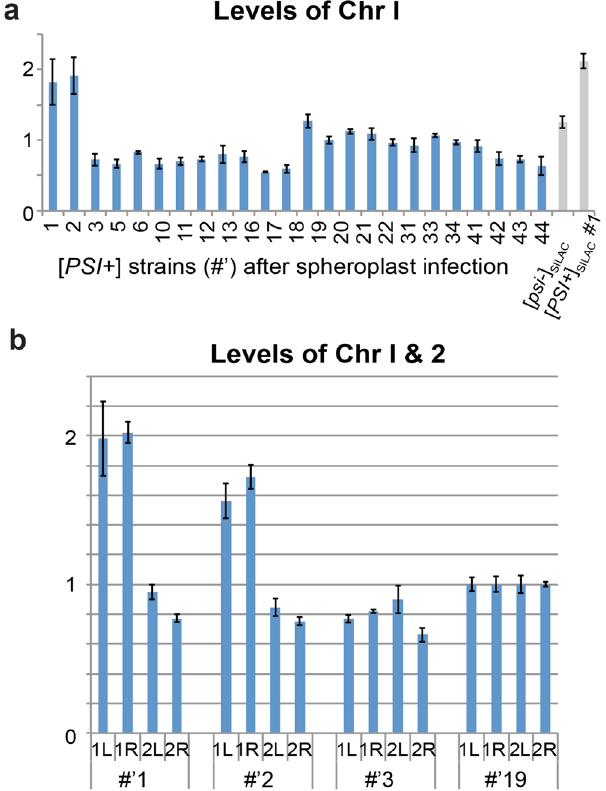
Figure 5. Disomy upon protein-based [ PSI + ] induction. ( a ) 24 strains verified to be [ PSI + ] by colouration were assessed for chromosome 1(Chr I) disomy by qPCR using primers against Chr I left arm. Relative Chr I copy number was determined compared to strain #’20. #’ designates strains that were generated by infecting spheroplasts with prion-containing yeast extract. ( b ) Candidate aneuploid strains #’1 and #’2, along with strains #’3 and #’19, were assessed for Chr I copy number by qPCR with Chr II as comparison, for both left and right chromosomal arms. Chromosome copy number was determined relative to strain 19. Error bars show standard deviation for technical